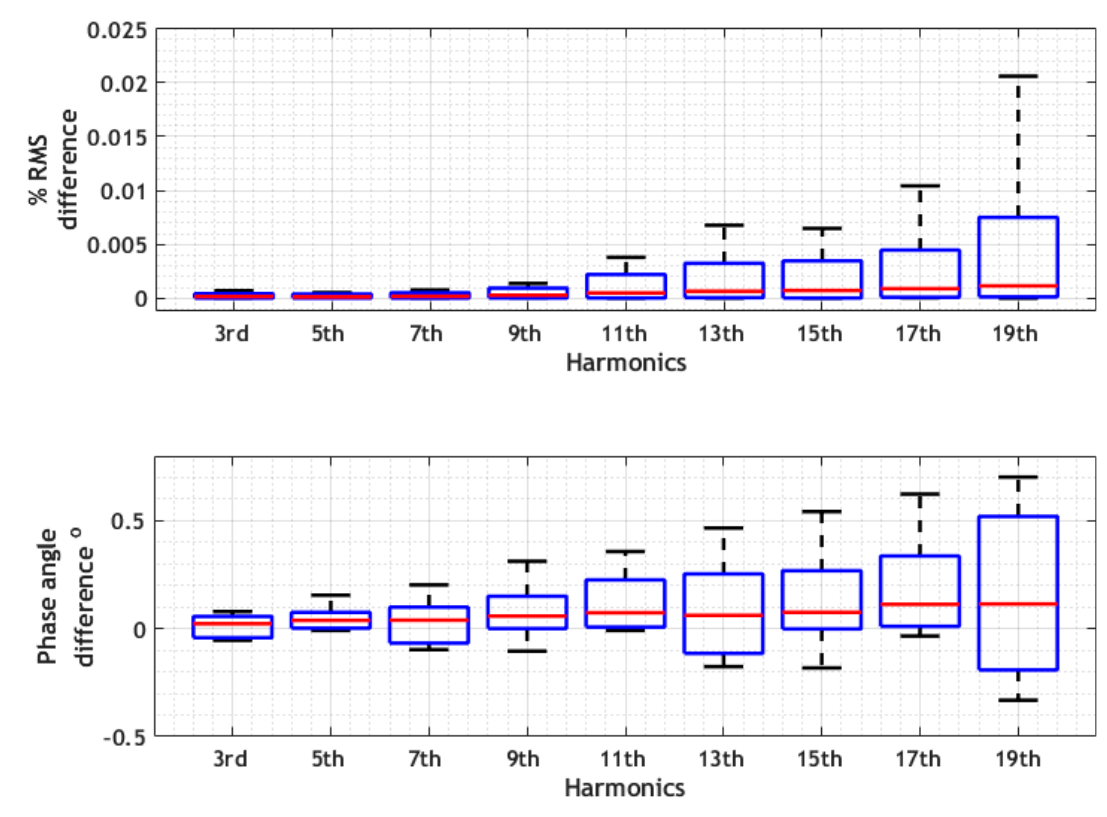
Figure 7. Percentage of RMS difference and phase angle difference in the calculated and measured results of LED loads.